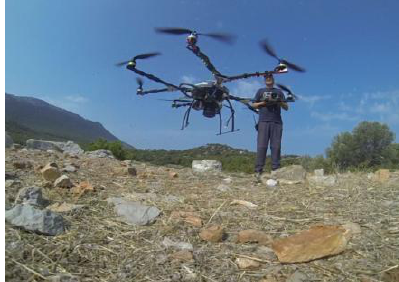
Figure 1. Oktokoper take-off subsequent to the flight plan transfer